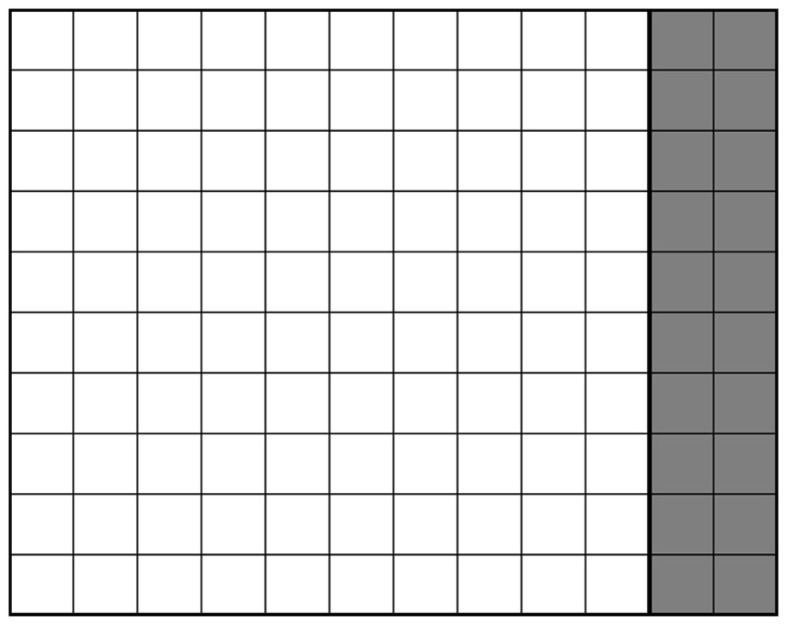
Final shape of CT in the case of a perfect simulation.